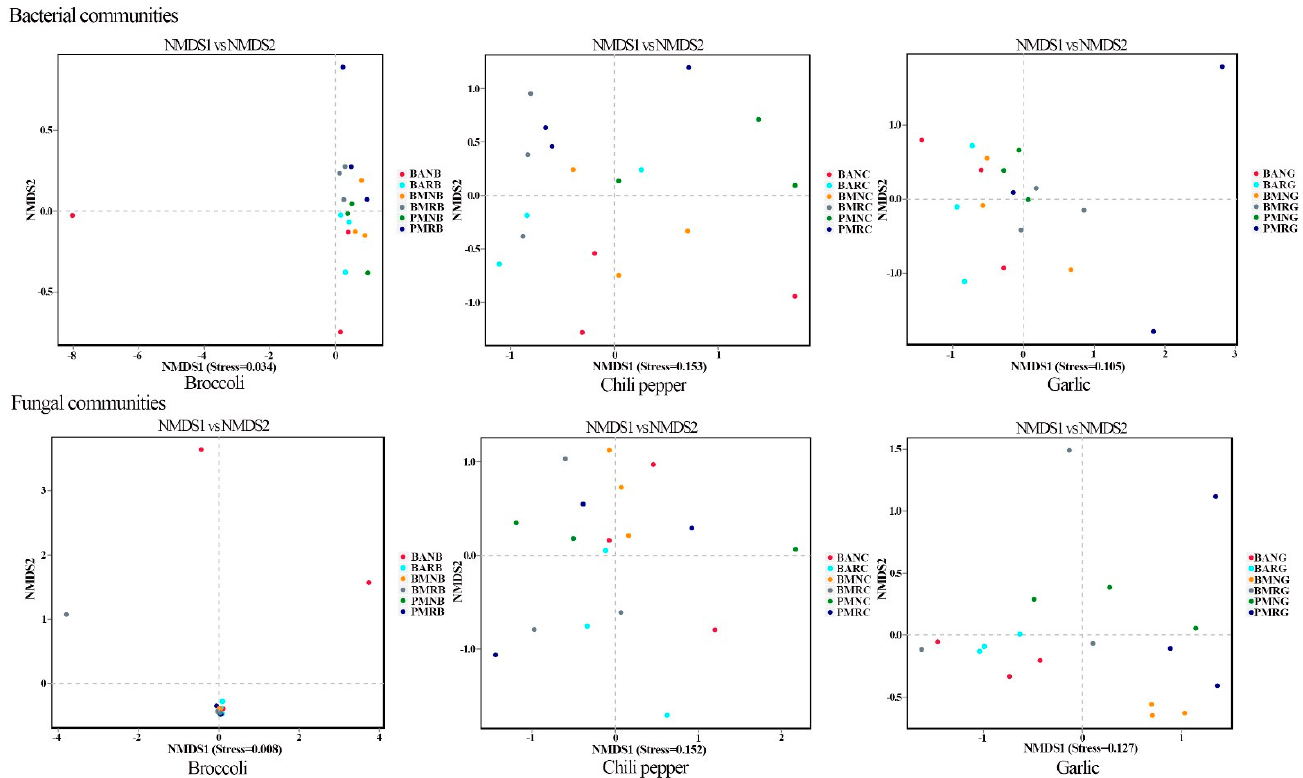
Figure 3. Non-metric multi-dimensional scaling (NMDS) analysis in three different vegetable fields Figure 1. OTU numbers of common bacteria and fungi in three vegetable fields under different under different treatments.